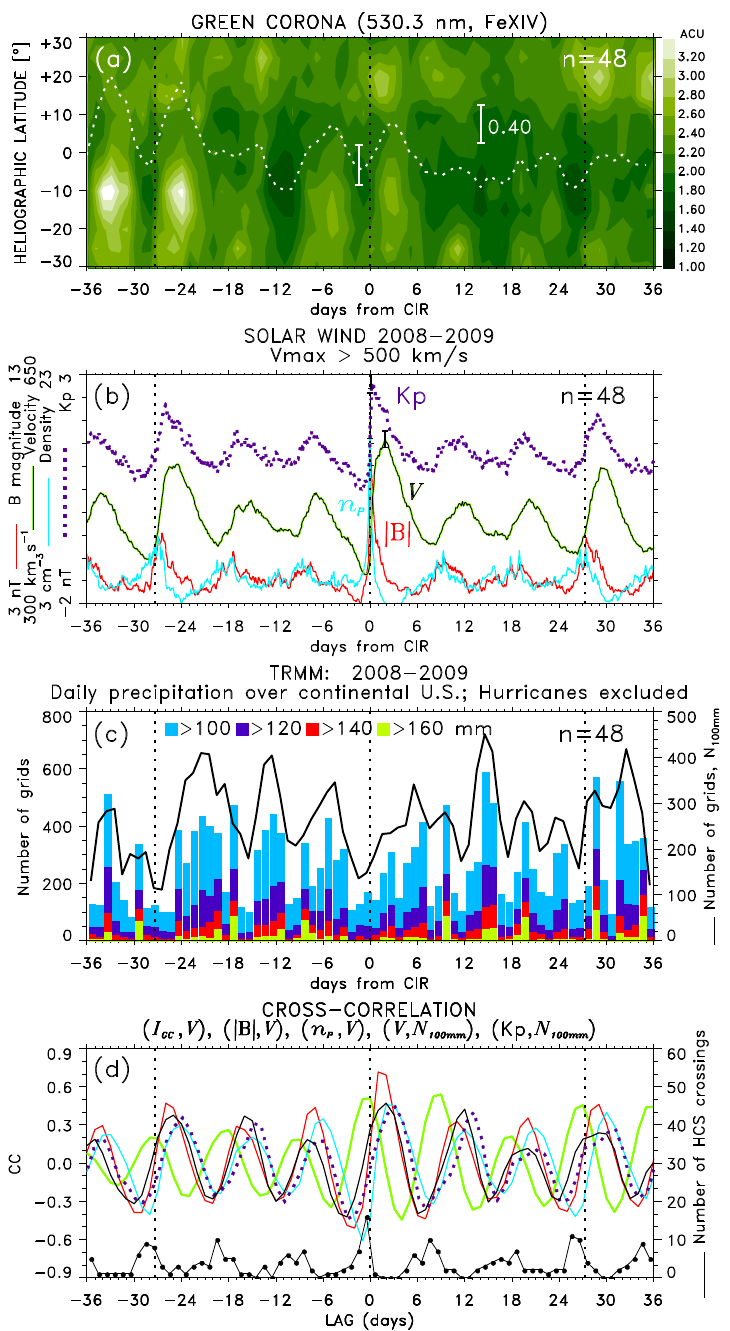
Figure 9. The same as Figure 7 but for years 2008 and 2009.